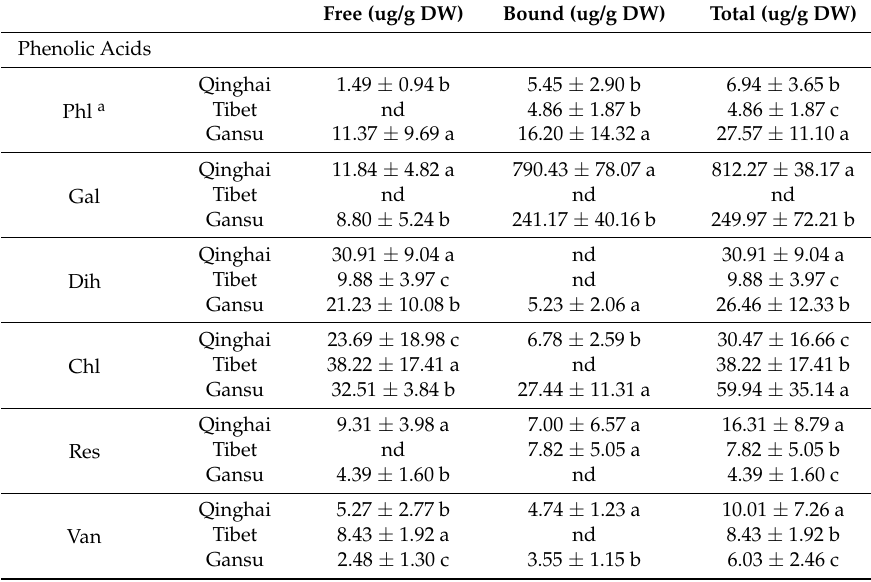
Table 4. Composition and content of phenolic acid and flavonoids in blue highland barley grains from different